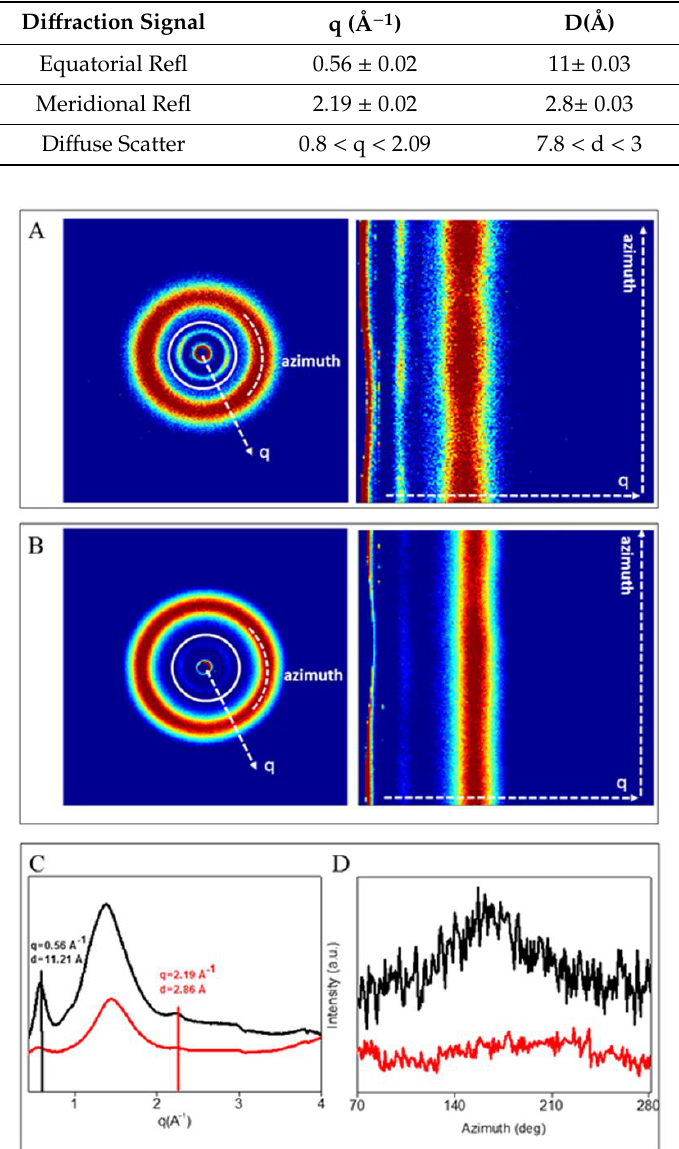
Figure 7. Di ff racted intensity distribution of collagen in native form ( A ) and treatment with acetic acid 90% ( B ). ( C ) 1D Wide Angle X-ray Scattering (WAXS) profiles of collagen in native form (black profile) and collagen treated with acetic acid 90% v / v (red profile). ( D ) Azimuthal profiles along equatorial direction extracted at q = 0.56 Å − 1 for both samples: native collagen (black profile) and acidic collagen (red profile).